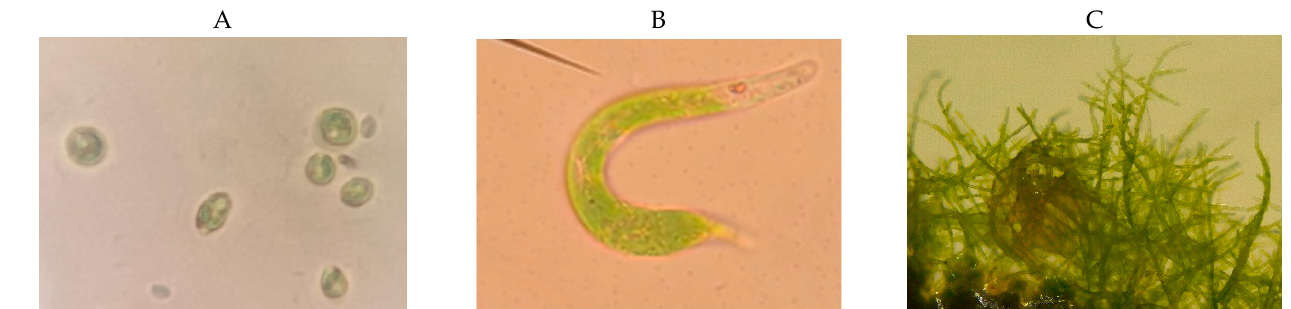
Figure 8. Microscopic images taken from axenic colonies isolated from PM5, grown on Gelrite plates with DSMZ medium 88. ( A ) Round ‐ and oval ‐ shaped cells of Chlamydomonas acidophila under 100x magnification; ( B ) a single cell of the protist Euglena mutabilis under 100× magnification; ( C ) Bryop ‐ sida sp. under a dissecting microscope at 5x magnification. sp. under a dissecting microscope at 5 ×